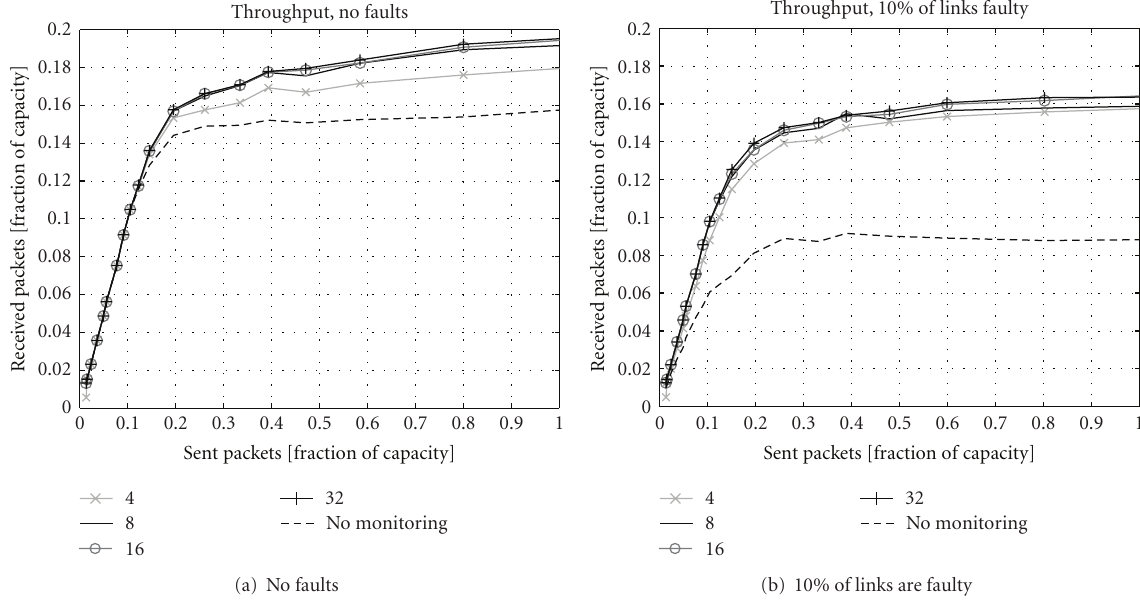
Figure 10: Throughput with di ff erent tra ffi c status granularity alternatives. C Size = 5 and data processing is enabled.